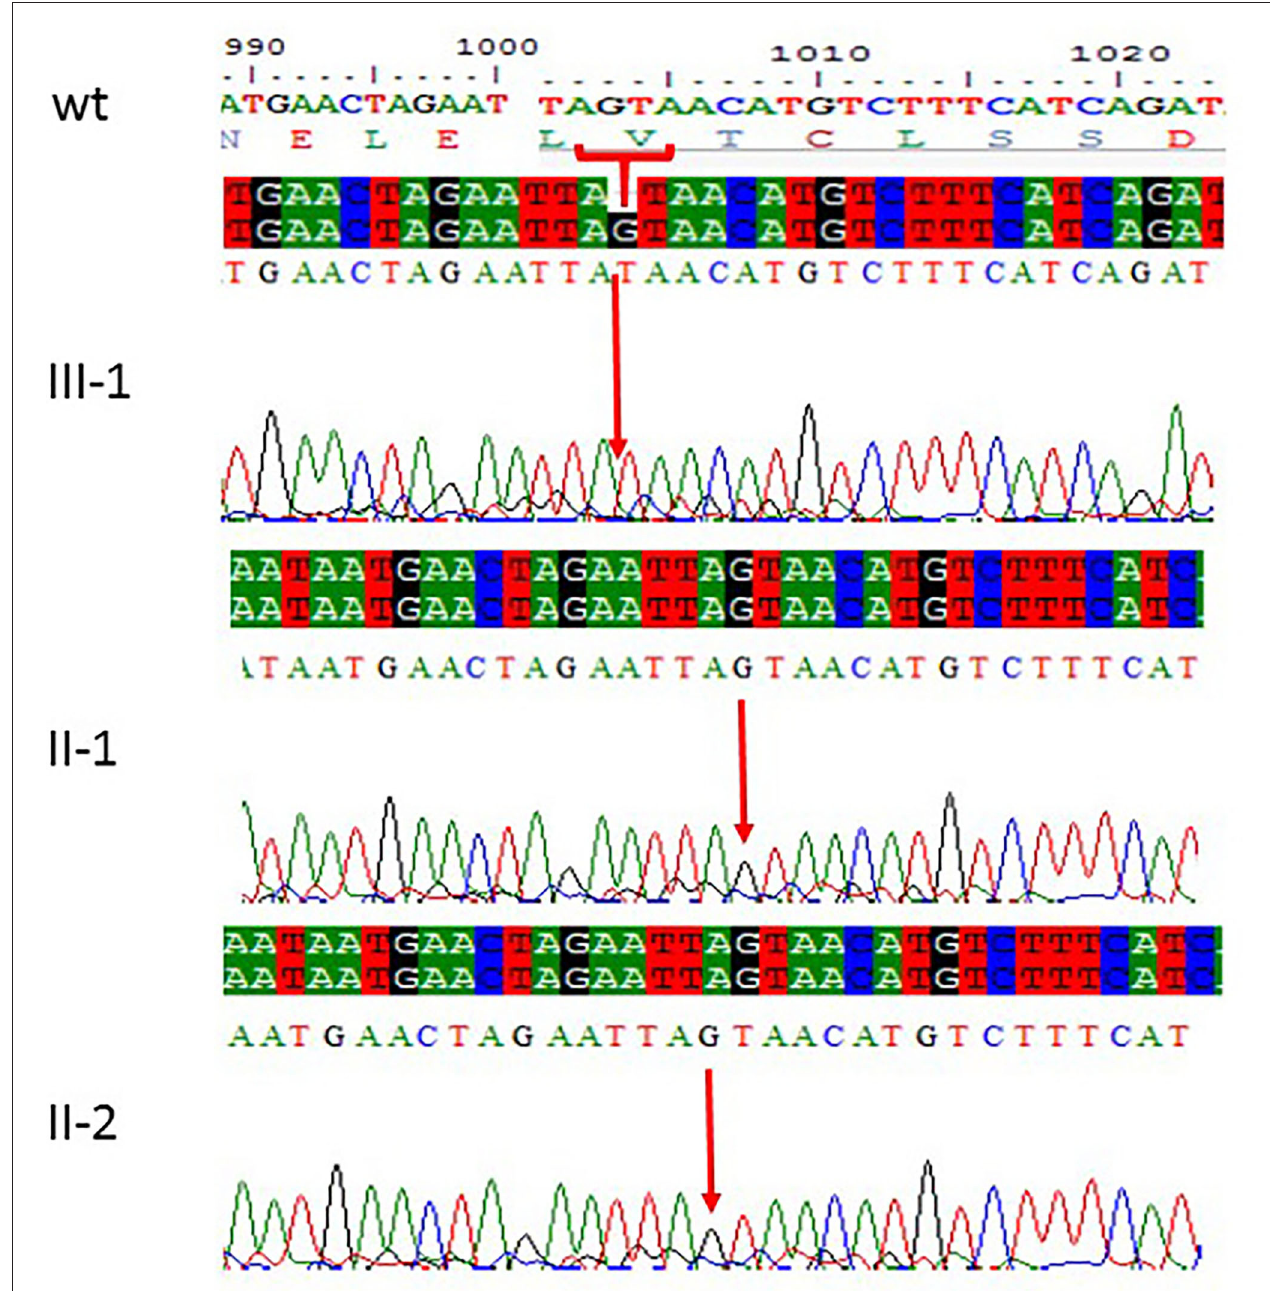
FIGURE 2 | Sanger sequencing chromatograms showing c.1003del. (p.Val335*) in exon 3 of ASPM gene mutation in family 1. Proband III-1 showed deletion of “G” bp as compared with the wild-type control, while both parents II-1 and II-2 are homozygous at this position. The upper panel shows the sequencing of the affected member, whereas the lower panel shows the parents who are carrier individuals; the arrow is pointing at the site of mutation.